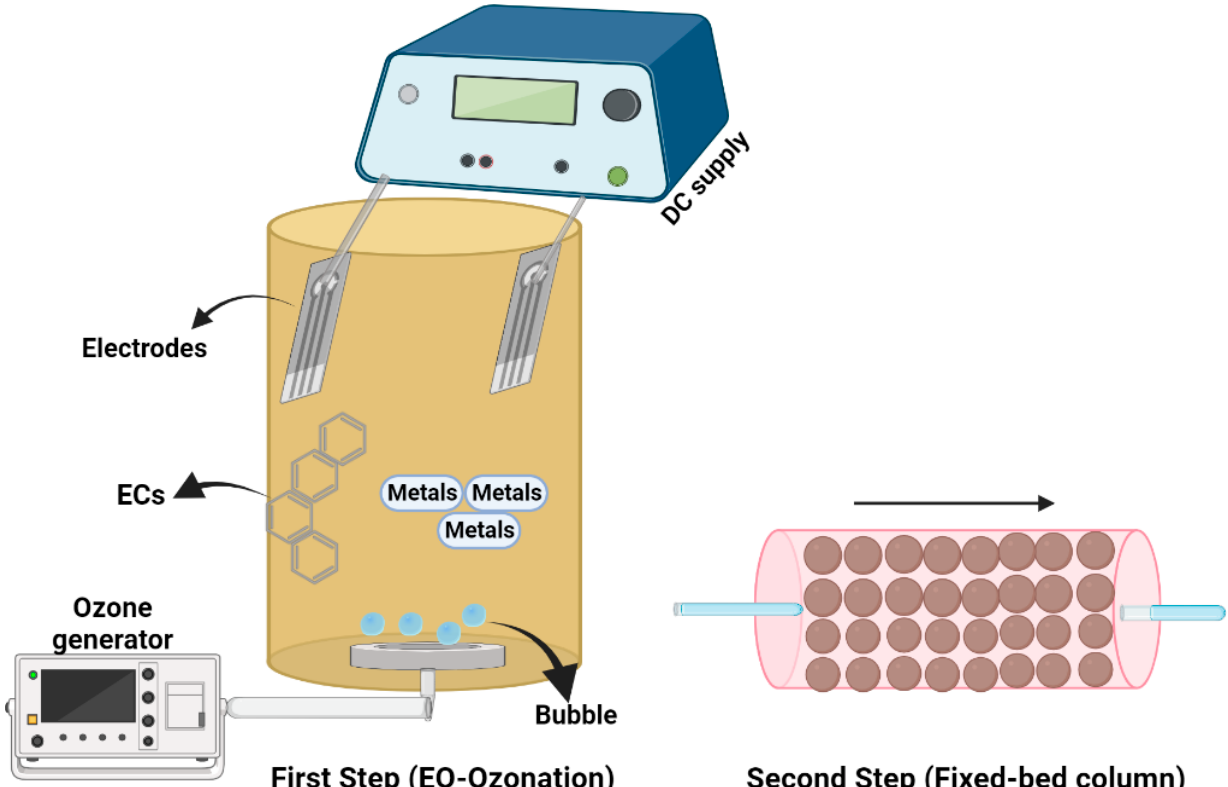
Figure 1. Schematic of the reactors.